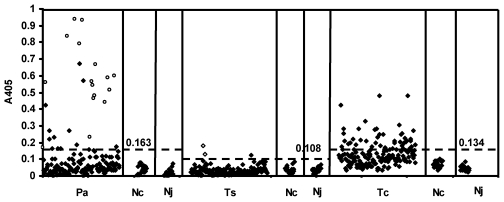
ELISA results for paragonimiasis (Pa), cysticercosis (Ts) and toxocariasis (Tc) from 208 persons.The surveyed persons (n = 208) include 168 and 40 (20 persons from Cameroon (Nc) and 20 from Japan (Nj)) with and without symptoms, respectively. ○, samples with Paragonimus eggs in the sputum. Serology could detect more cases than microscopical examination of sputum and was expected to be more sensitive for detection of paragonimiasis including immature adult stage [11]. ◊, samples positive against the recombinant antigen 100% specific to cysticercosis by immunoblot [17]. The broken line denotes the respective cut-off value for each disease and each cut-off value is shown.